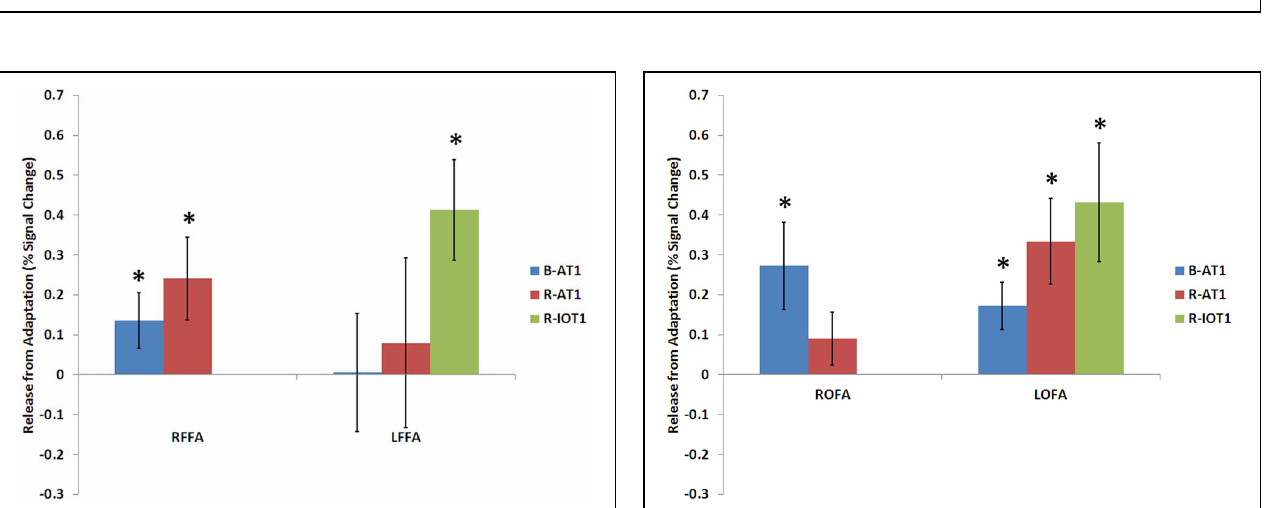
FIGURE 4 | Core system regions-of-interest identified with the functional localizers (all brains standardized to Talairach space). All six regions of the core system were identified in B-AT1 and R-AT1. Due to the location of the